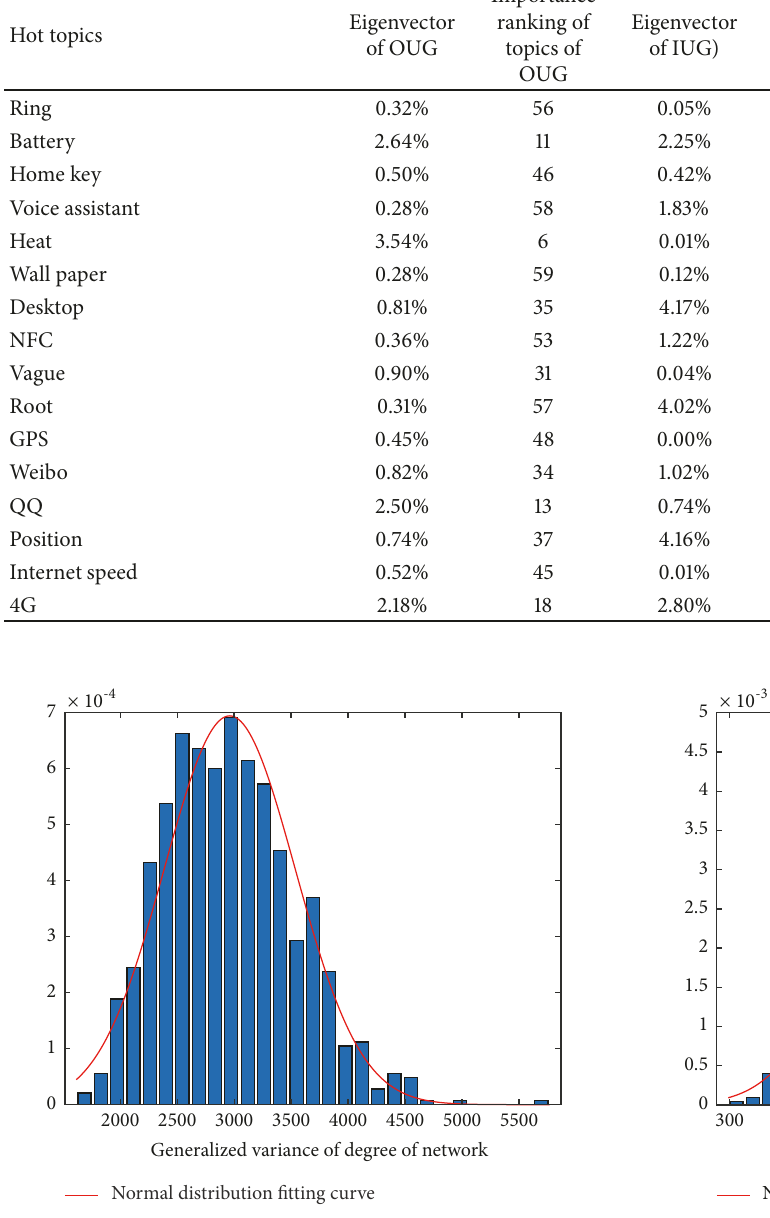
Figure 7: Generalized variance of degree of network of null model of OUG.